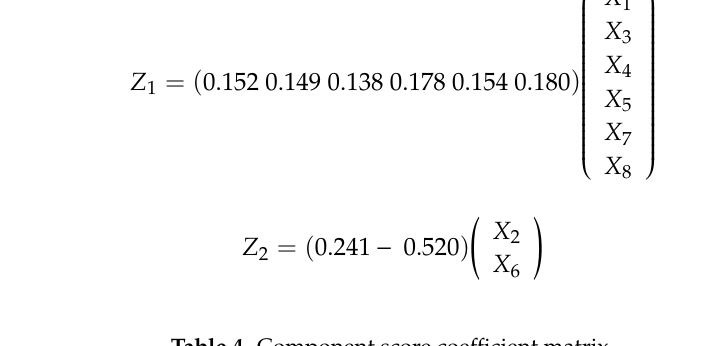
Table 4. Component score coe ffi cient